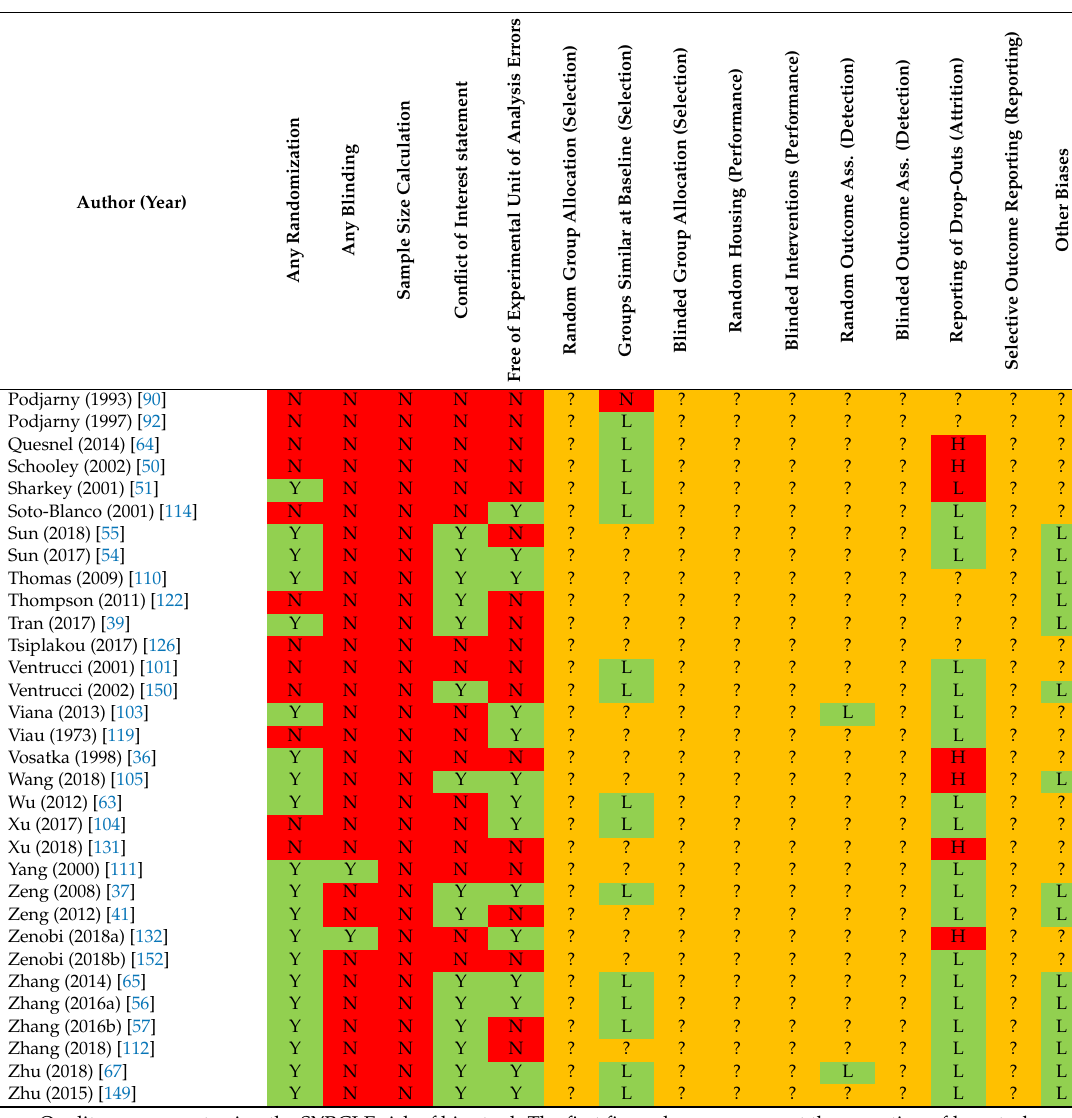
Quality assessment using the SYRCLE risk of bias tool: The first five columns represent the reporting of key study quality indicators; the last ten columns entail the risk of bias assessment. Y = yes, reported; N = no, not reported; H = High risk of bias; L = Low risk of bias; ? = unclear risk of